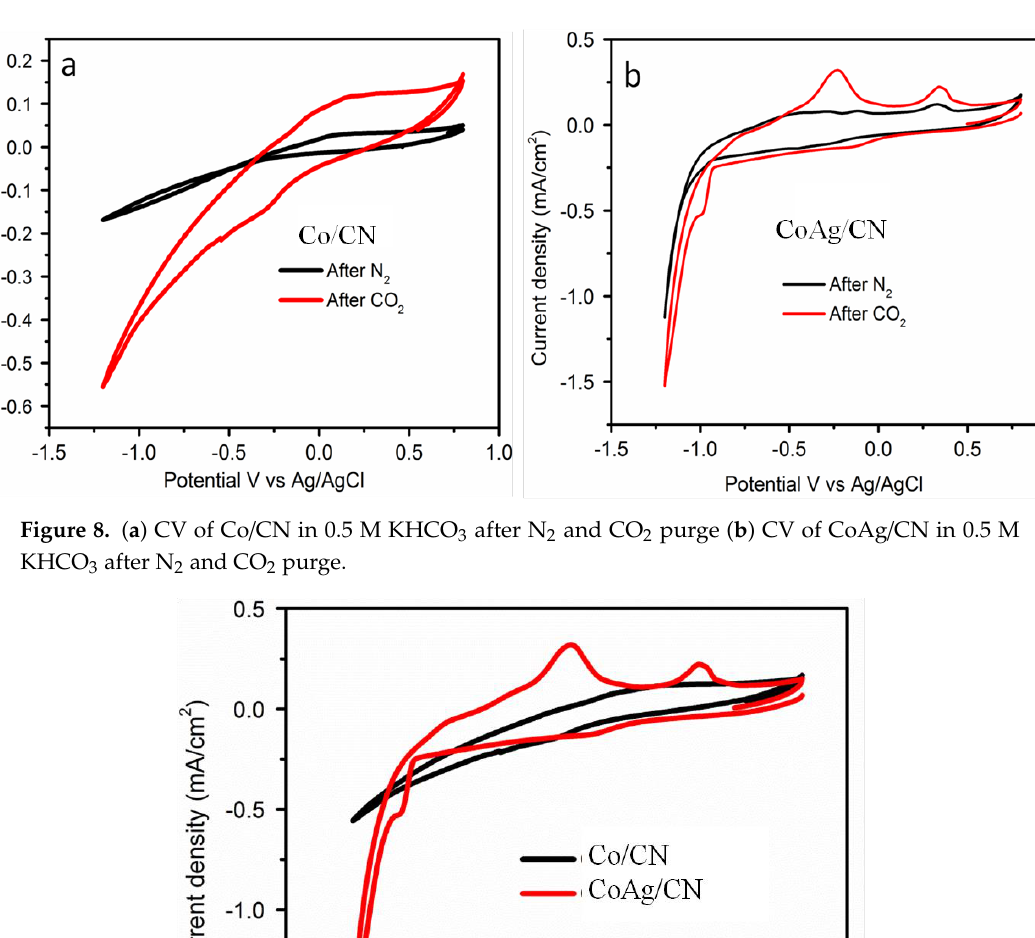
Figure 10. Cyclic voltammetry scans of CoAg/CN with RRDE. Disc electrode was scanned between 0 and −1.2 V versus RHE, the ring electrode was held at 0.9 V versus RHE. ( a ) Initial CV scan for N 2 purged electrolyte. Ring electrode was held at 0.9 V versus RHE. ( b ) CV scan for the system after CO 2 saturation with the ring held at 0.9 V versus RHE. The experiments were all performed at room temperature. Scan rate: 100 mV s −1 . Constant rotation (1500 rpm) was used.